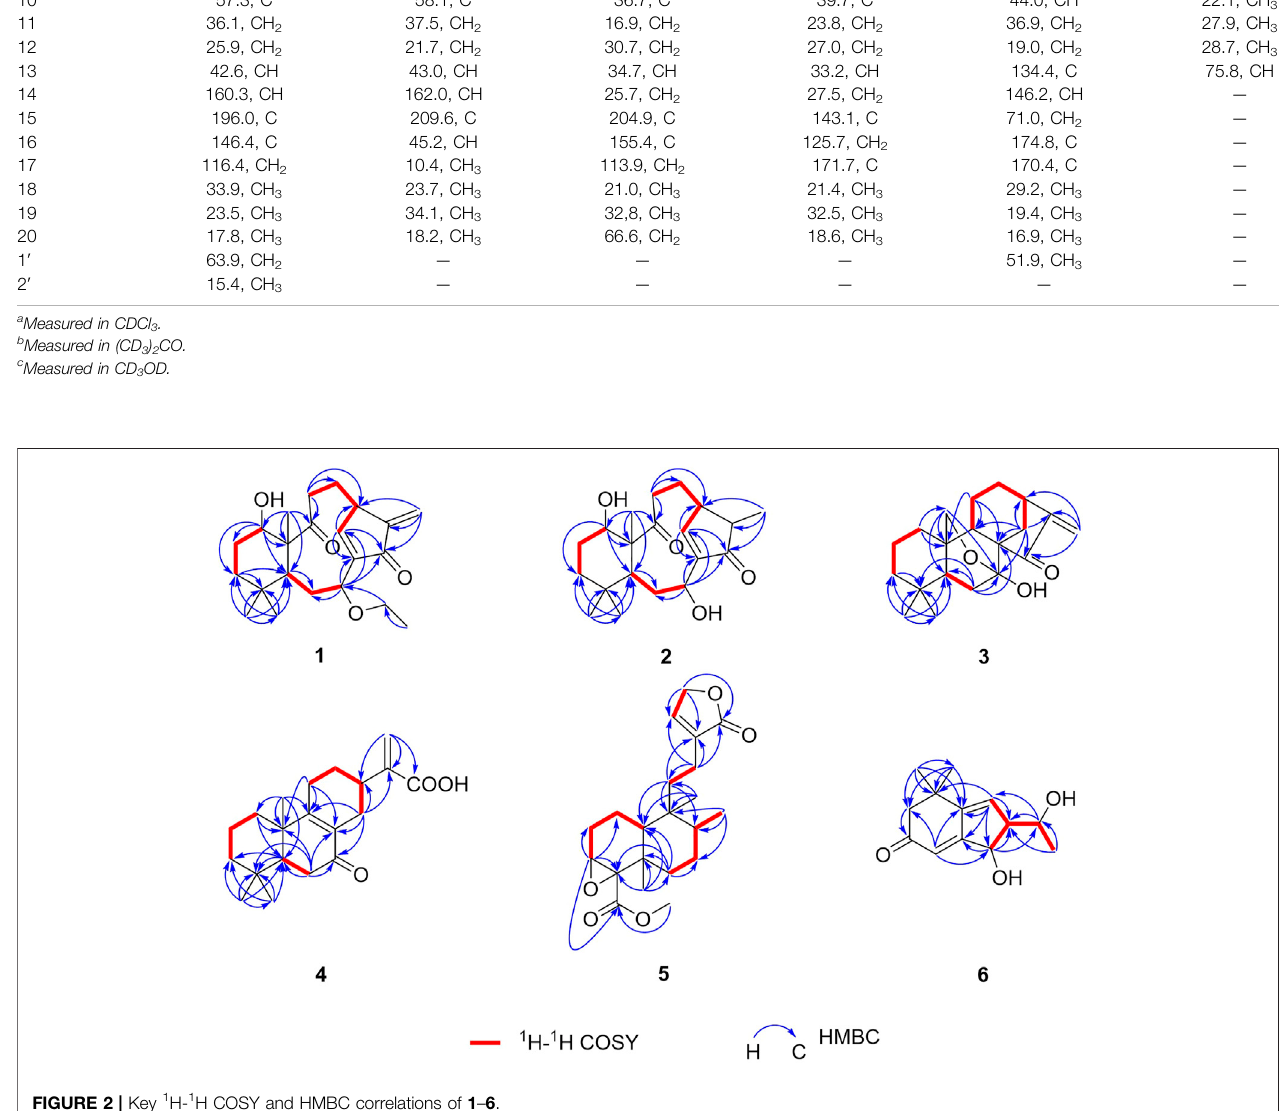
FIGURE 2 | Key 1 H- 1 H COSY and HMBC correlations of 1 – 6